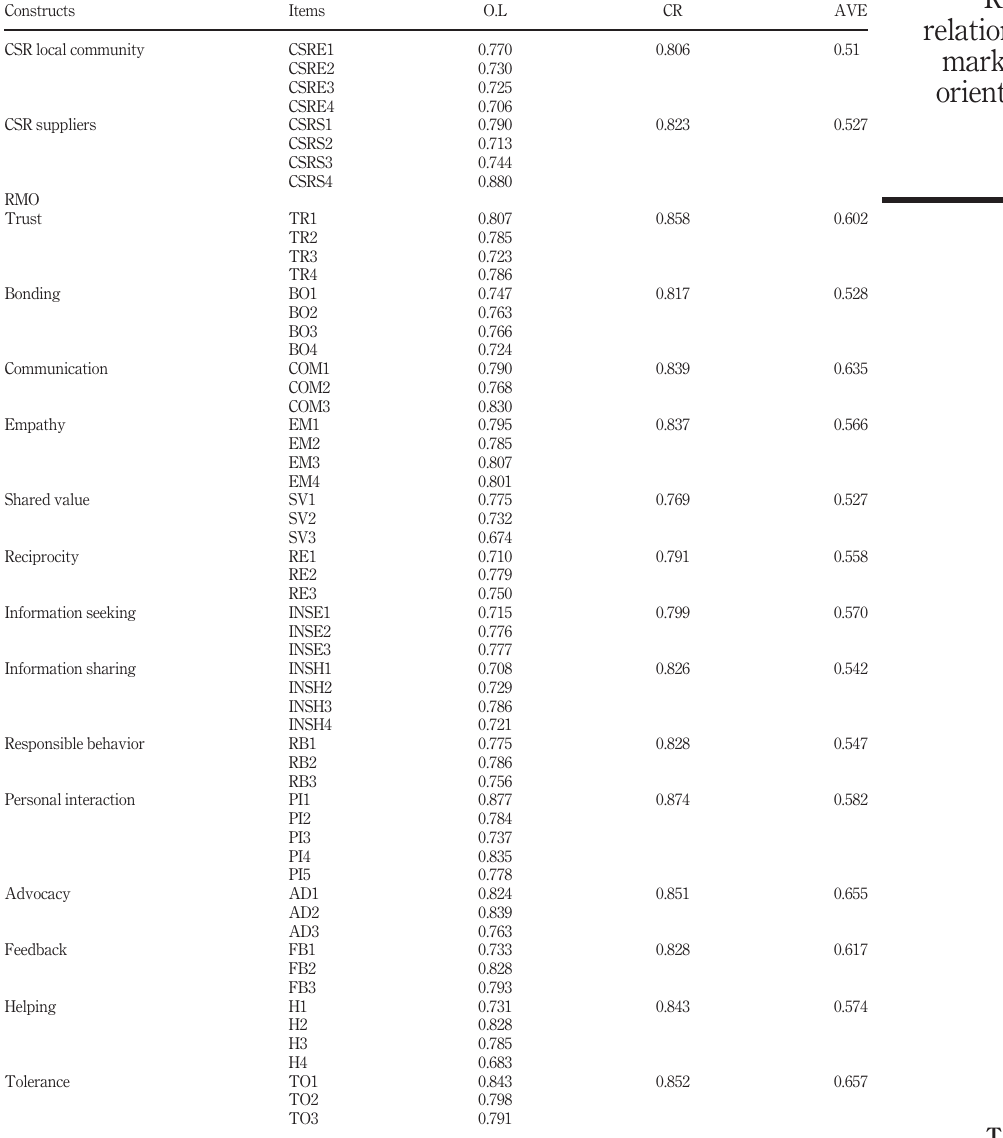
Table 2. Outer loading, reliability and AVE of